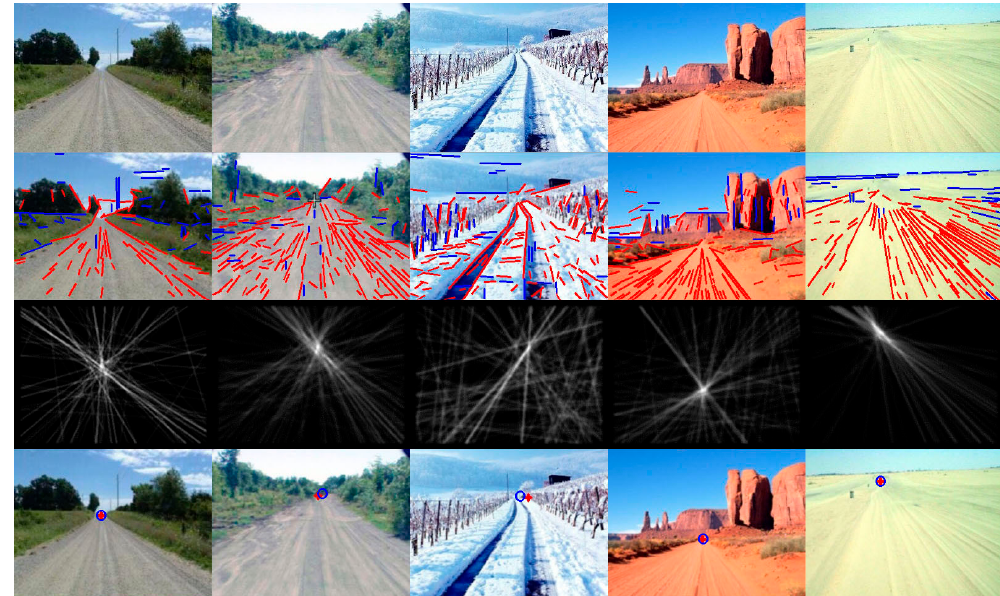
Figure 7. Vanishing point detection and road segmentation examples for unstructured roads using the study’s proposed method. The first row images are the input images. The second row images are the detected line segments. The third row images are the line space voting images. The fourth row images show the estimated VPs and the ground truth (the red cross is the estimated VP location; the blue circle is the ground truth).